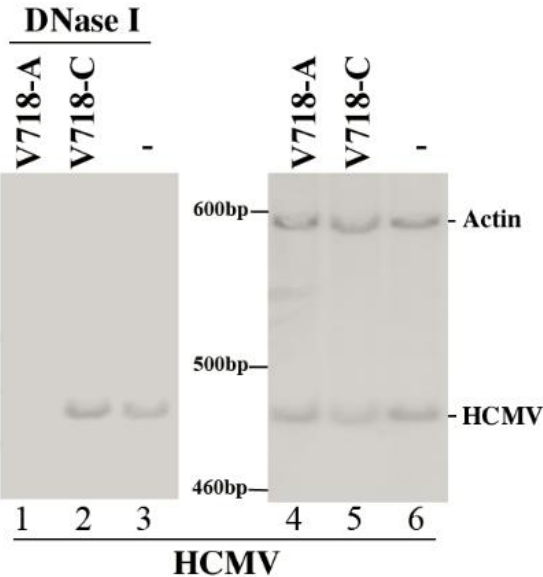
Figure 6. The levels of HCMV encapsidated DNA and total intracellular DNA. DNase I-treated DNA samples (lanes 1–3) or total DNA (lanes 4–6) were prepared from cells without ribozyme (-, lanes 3 and 6) or with ribozyme V718-A (lanes 1 and 4) and V718-C (lanes 2